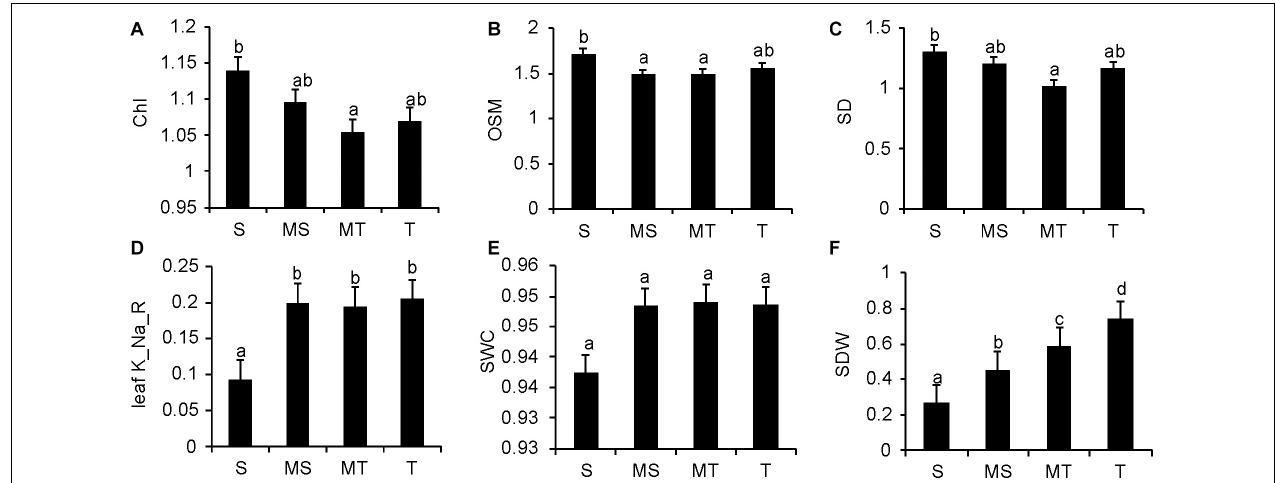
FIGURE 6 | Mean performance of the significant traits (selected in the regression analysis and correlation analysis; Tables 3 , 4 ) in the four clusters. Cluster 1, sensitive (S; STI < 0.35); Cluster 2, moderately sensitive (MS; STI 0.35-0.50); Cluster 3, moderately tolerant (MT; STI 0.50-0.65); Cluster 4, tolerant (T; STI > 0.65). (A–F) show the mean performances of chlorophyll content, leaf sap osmolality, stomatal density, leaf K + /Na + ratio, shoot water content and shoot dry weight in the four clusters, respectively. Data are presented as the mean ± SE ( n = 5). Different lowercase letters indicate a significant difference ( P < 0.05).